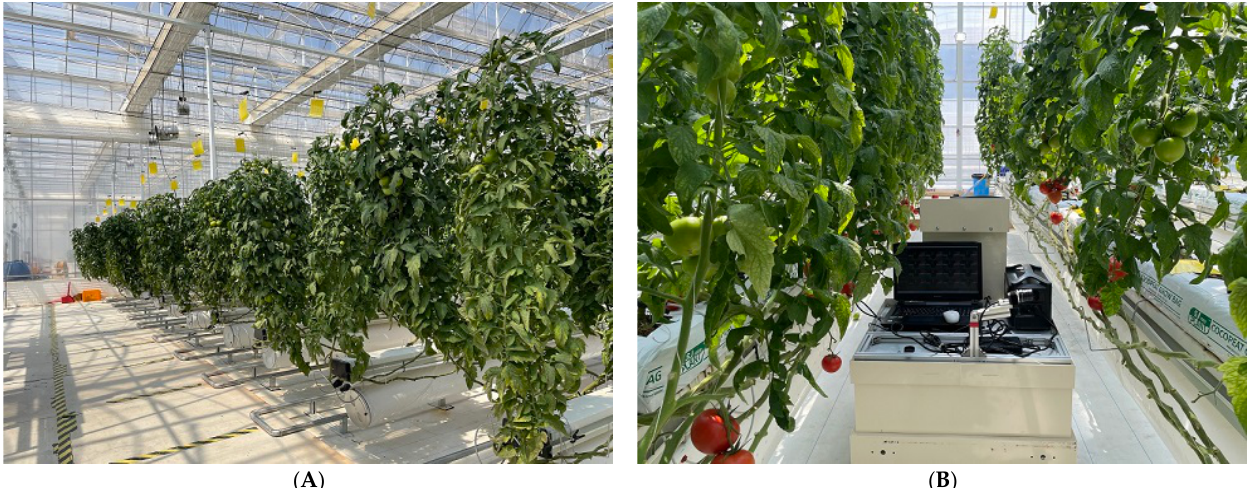
Figure 4. The actual image of the hydroponic greenhouse that we obtained tomato images ( A ) and the monitoring robot system used in this study ( B ).